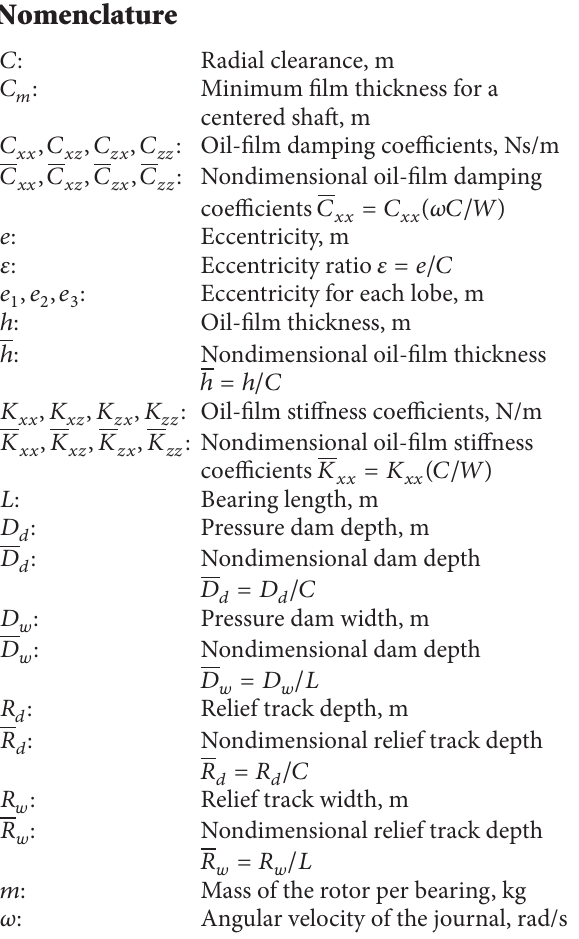
(6) The incorporation of pressure dam and relief track in a three-lobe journal bearing increases the stability and threshold speed but the depth of pressure dam and relief rack has to be set very carefully because it has great significance on overall